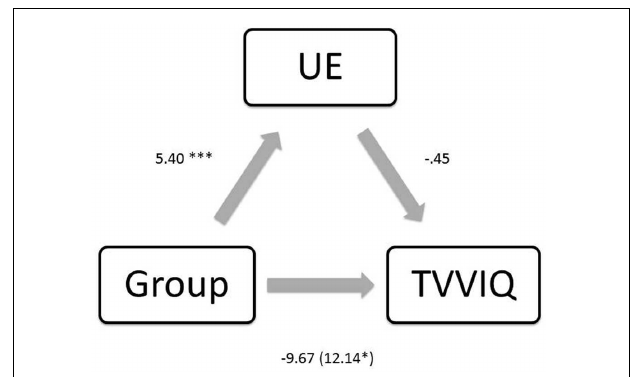
FIGURE 4 | Regression coefficients for the relationship between group and TVVIQ (imagery) are not mediated by UE (schizotypy). ∗ p < 0.05, ∗∗∗ p <